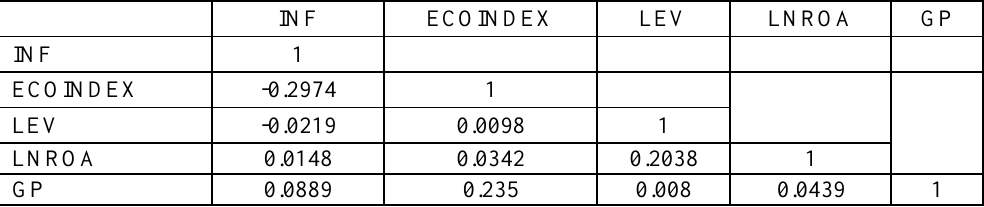
Table (5). Correlation Matrix among Independent and Control Variables INF ECOINDEX LEV LNROA GP